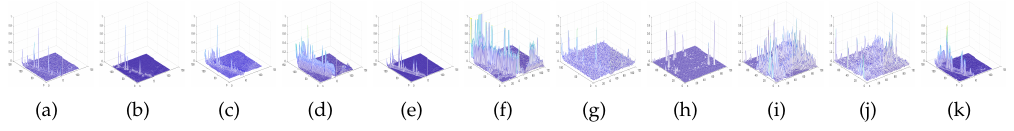
Figure 19. Three-dimensional plots of detection results for the Pavia dataset. ( a ) GRX; ( b ) BJSRD; ( c ) LSAD; ( d ) LRASR; ( e ) LSMAD; ( f ) CBAD; ( g ) CRD; ( h ) LRX; ( i ) LKRX; ( j ) OSP; and ( k ) BDSLRR.